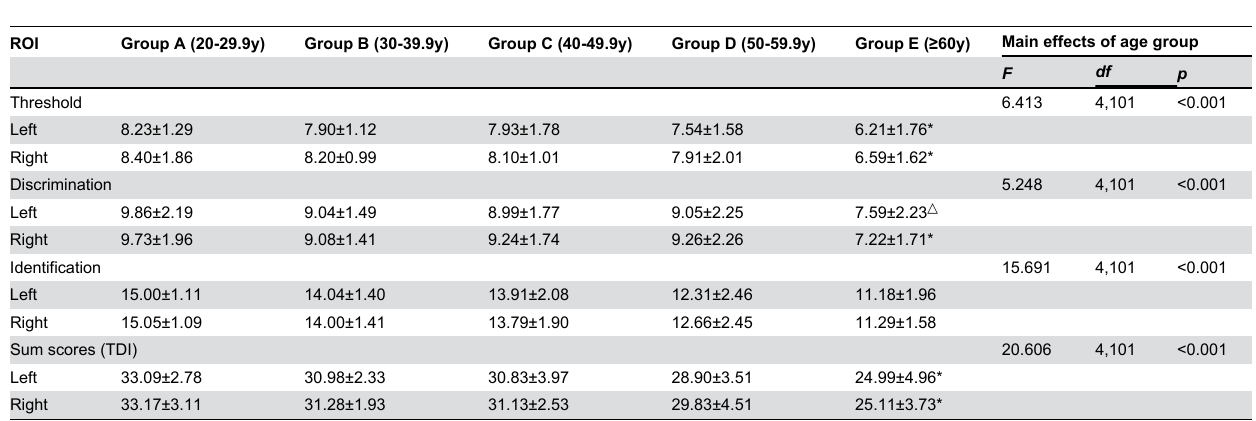
Table 2. Scores of odor threshold, odor discrimination, odor identification and the sum